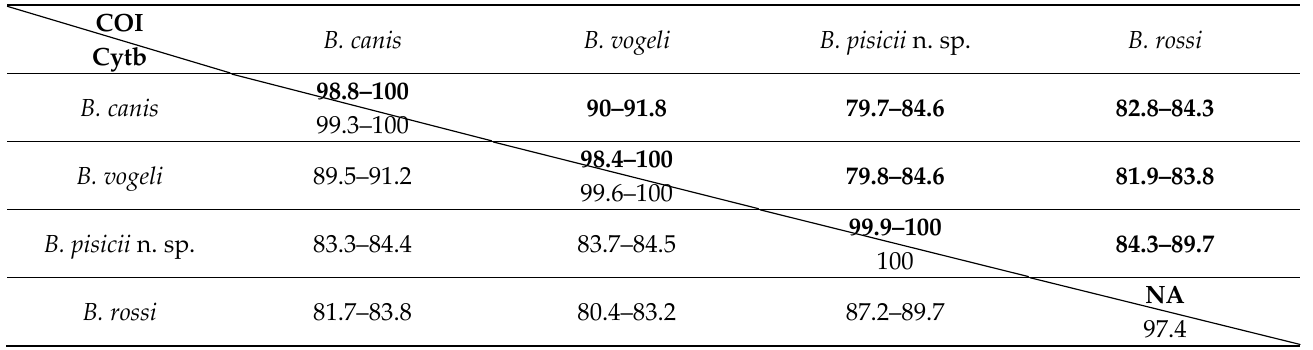
Table 2. Pairwise nucleotide sequence identities (%) of Cytb (lower left) and COI (upper right) genes for B. canis , B. vogeli , B. pisicii n. sp., and B. rossi.